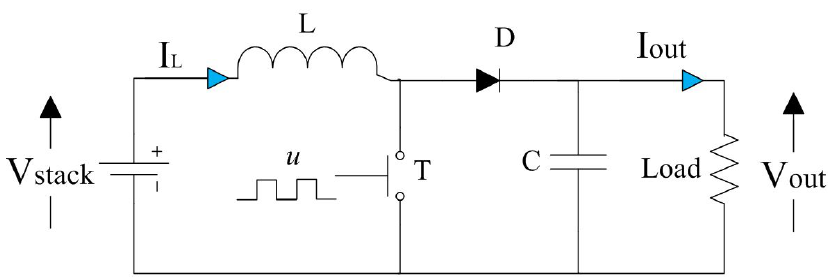
Figure 4. Boost converter circuit diagram.